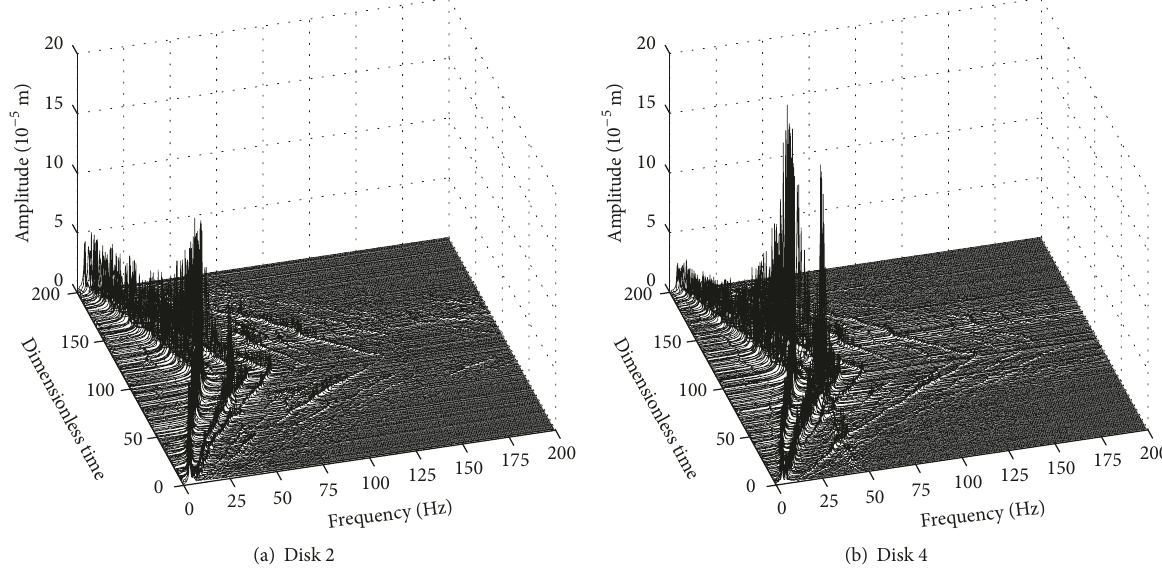
Figure 6: Spectrum cascade of the horizontal response of disks 2 and 4, experimental results. 𝜆 = −1.65 .